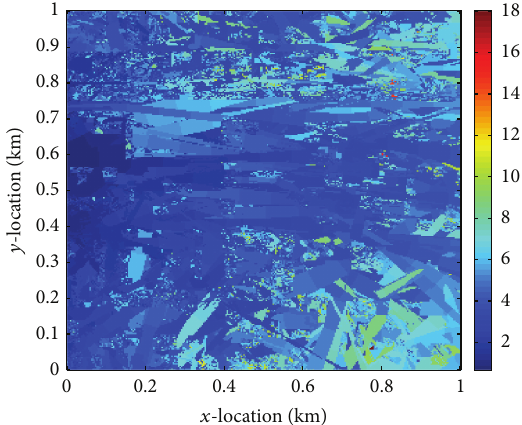
Figure 2: Simulated TOA ( 𝜇 s) data from the MCD for downtown State College, PA, for Scenario A. Data plotted for the dominant